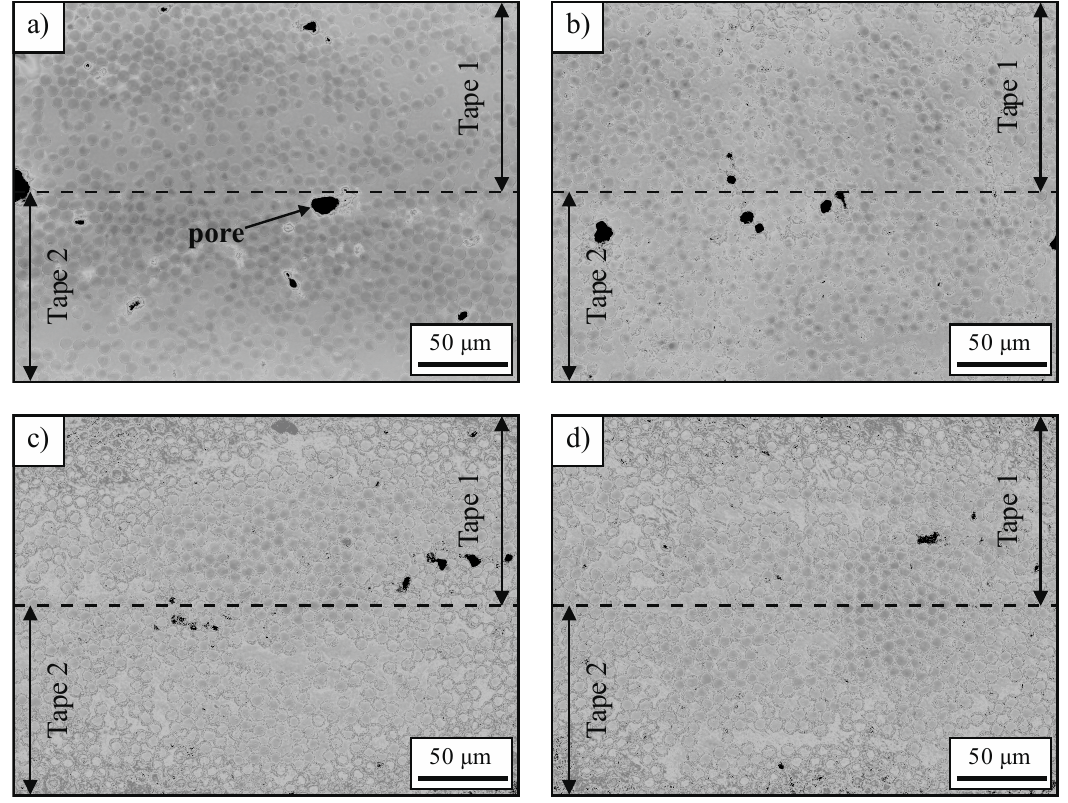
Figure 4. Representative Laser Scanning Microscopy (240× magnification, stitched) of the cross-sectional area of the manufactured carbon-fiber reinforced polyetheretherketon (PEEK/CF) specimens. ( a ) Reference experiment. ( b ) F1 experiment. ( c ) F2 experiment. ( d ) F3 experiment.